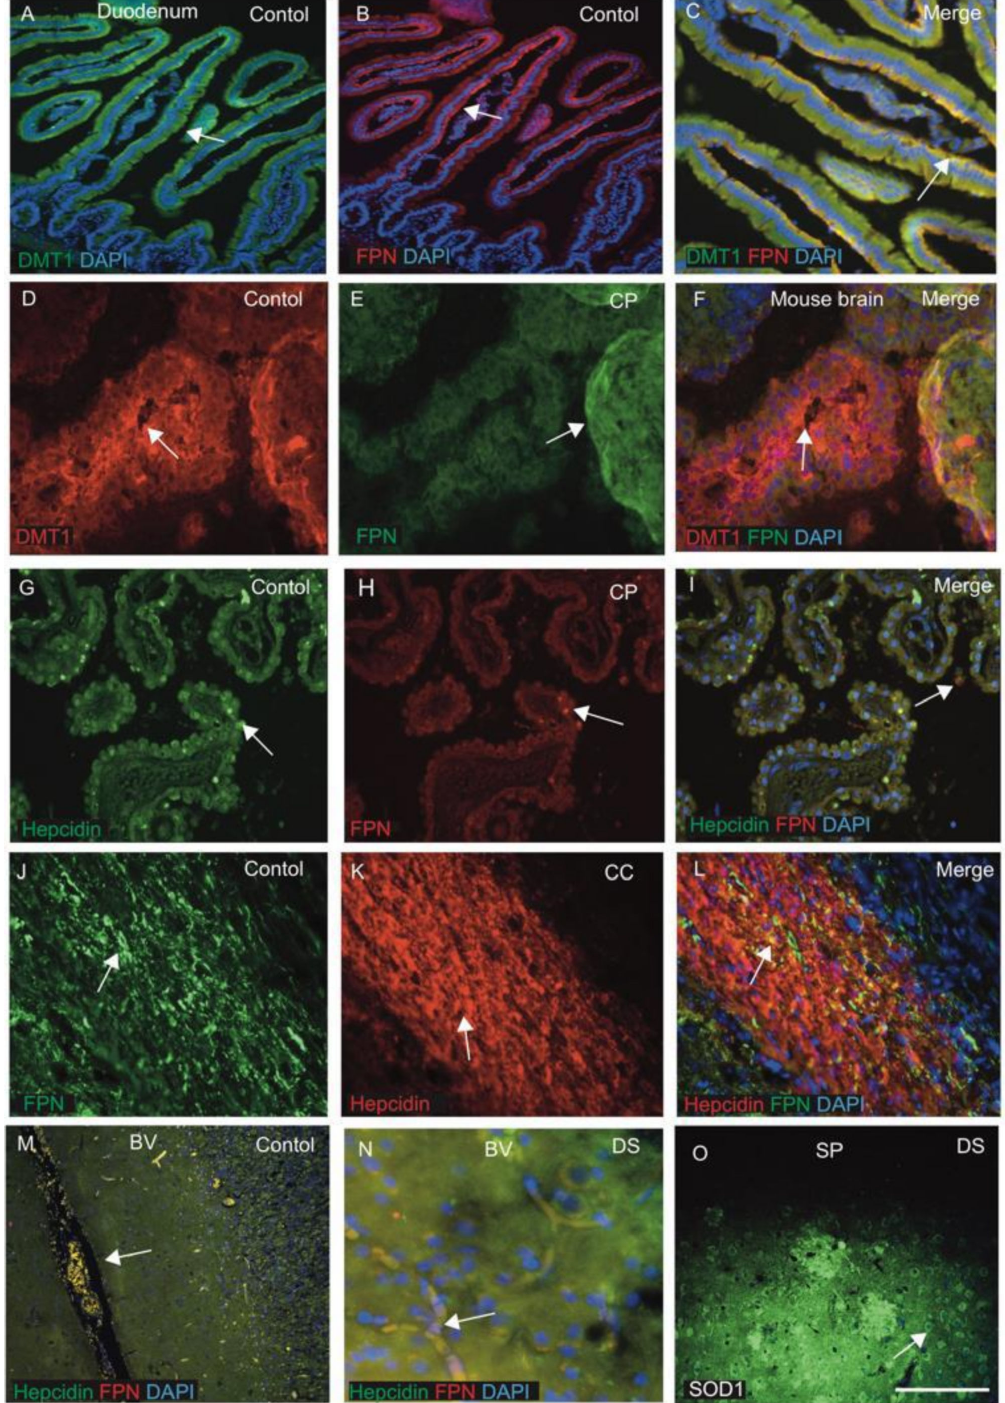
Figure 4. DMT1, FPN and hepcidin regulate endothelial transport and SOD1 modulates redox balance in DS